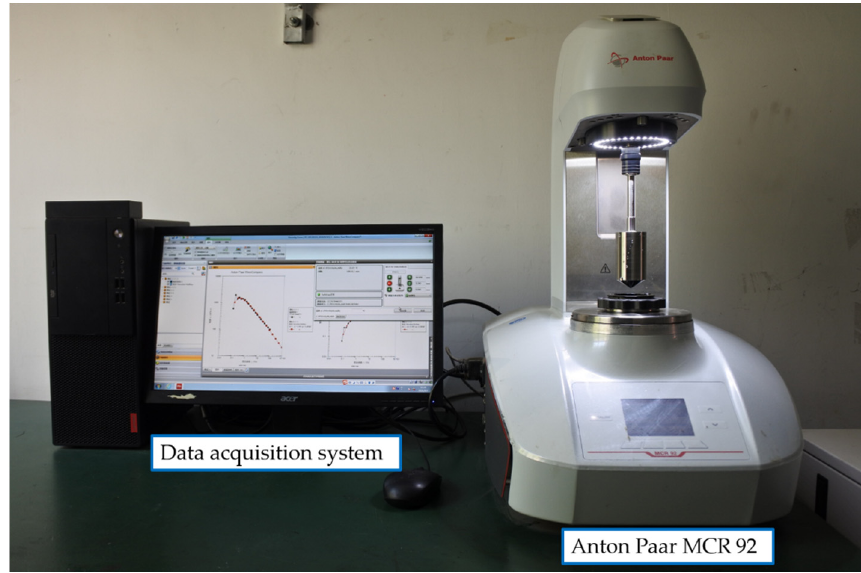
Figure 1. Advanced rheometer (Anto Paar MCR 92). Table 2. Rheological test results of Carbopol aqueous solution and glycol aqueous solution for